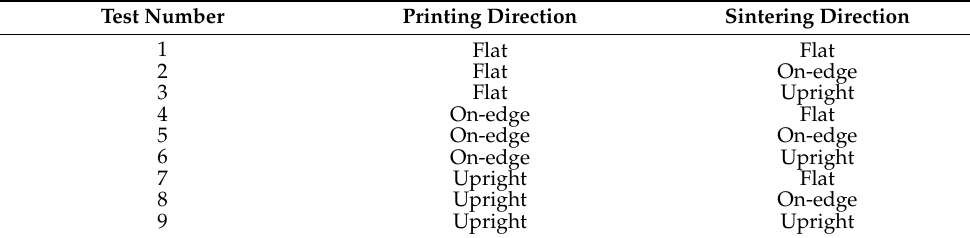
Table 3. Combinations for printing and sintering directions of tensile